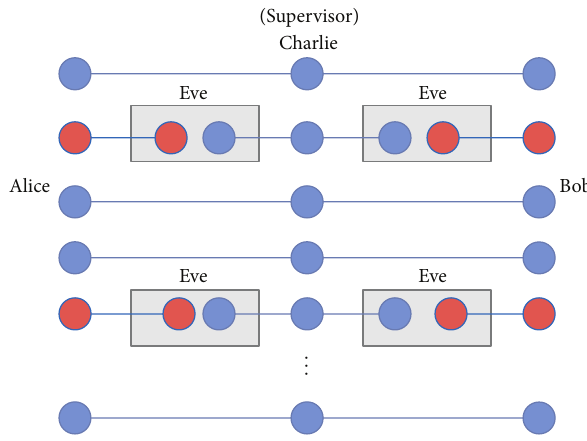
Figure 6: The scenario of Eve inserts EPR pairs.